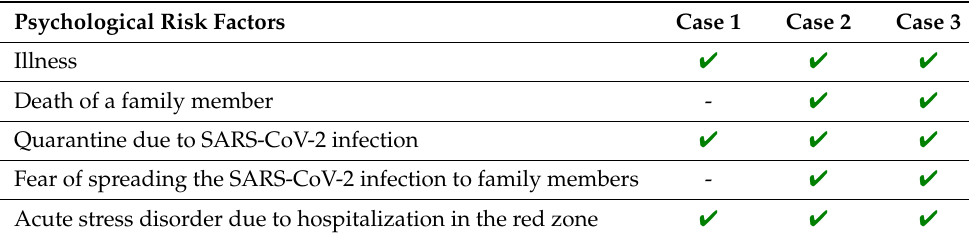
Table 2. Suicide motives and the psychological risk factors.